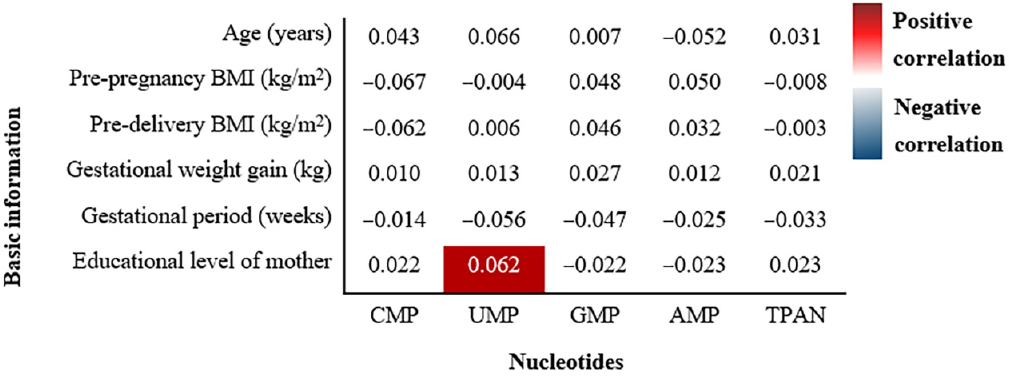
Figure 4. Correlations of basic demographic characteristics and TPAN contents in breast milk. The correlation coefficients (r) were shown in the graph. correlation coefficients (r) were shown in the